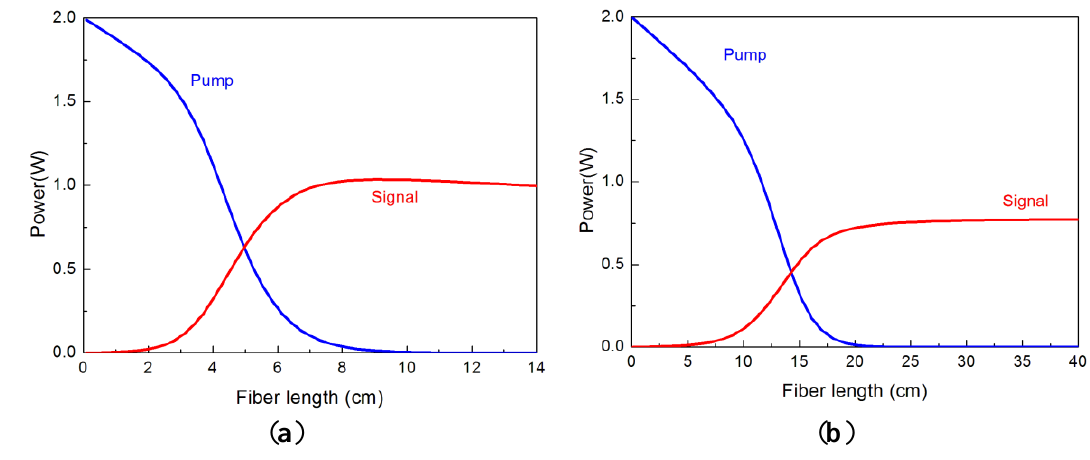
Figure 4. Theoretical predictions of the 1950-nm output single and residual pump powers dependence on fiber length for ( a ) a silicate fiber master-oscillator power amplifier (MOPA) and ( b ) a silica fiber MOPA. The red and blue solid-curves show the output signal and residual pump power as a function of the fiber length, respectively.